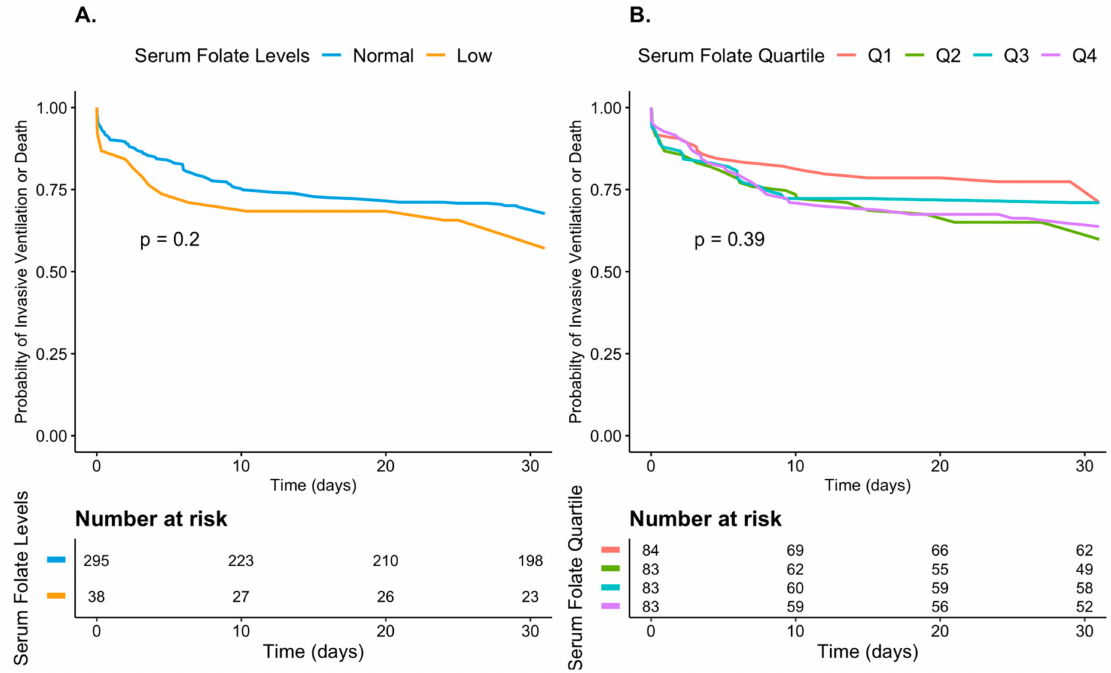
Figure 2. Accumulative probability plot for a composite outcome of invasive ventilatory support and mortality in patients hospitalized with COVID-19 A. For normal-range and low folate levels B. For quartiles of the patients’ folate levels. No significant difference in the probability for a composite outcome was observed between patients with decreased and those with normal-range folate levels ( A ) or according to quartiles of folate levels ( B